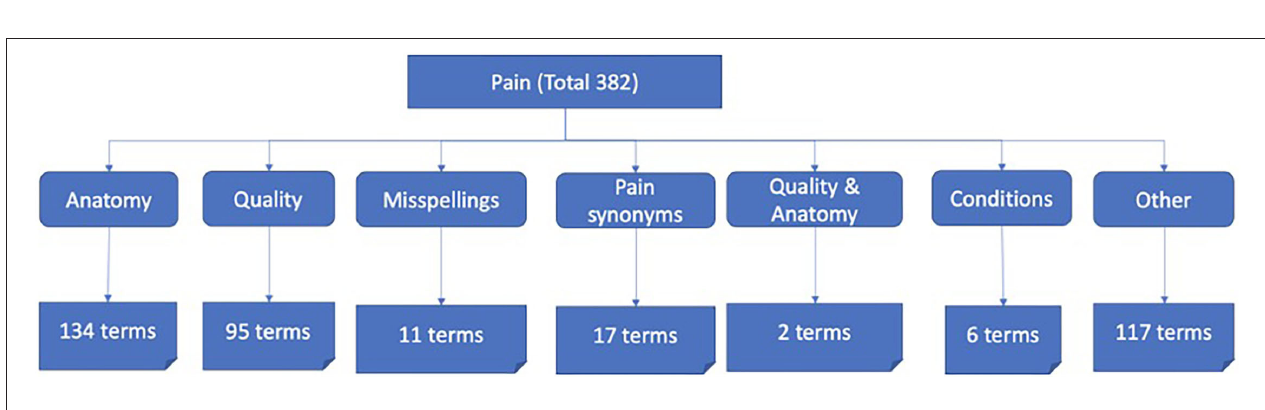
FIGURE 4 | Distribution of terms within pain